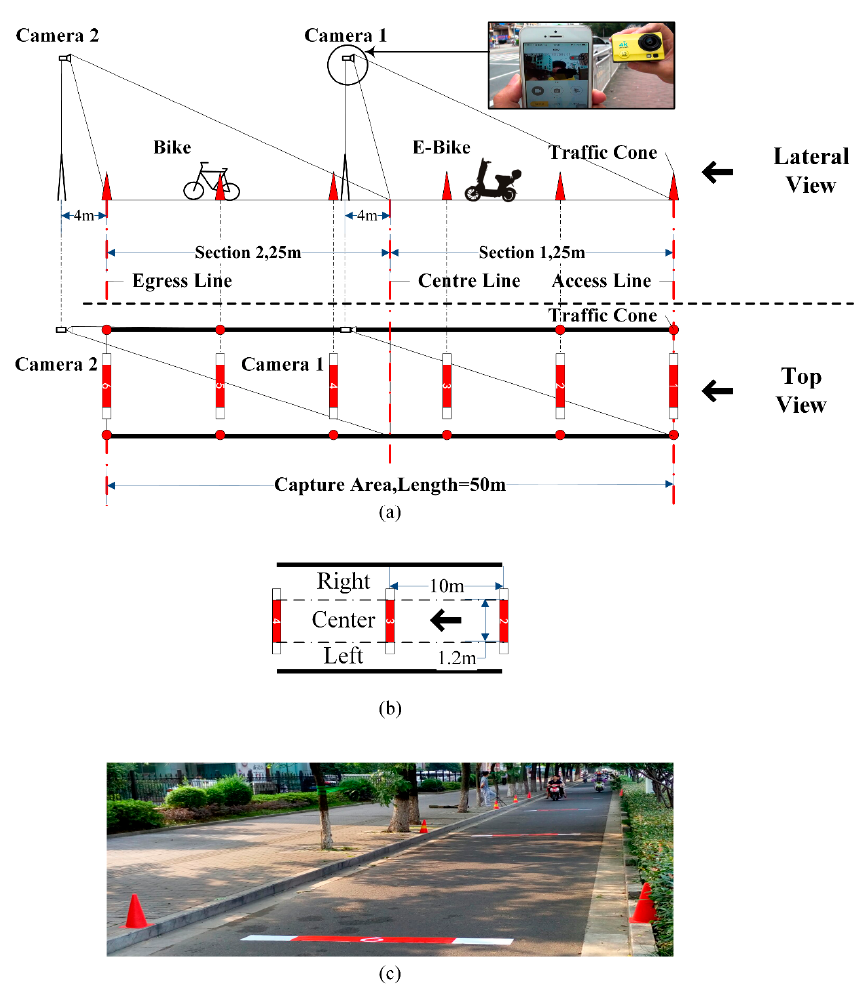
Figure 1. ( a ) Setting details for field observation and wifi camera adopted; ( b ) track surface markings; ( c ) real photo for installation of traffic cones and marking tapes.